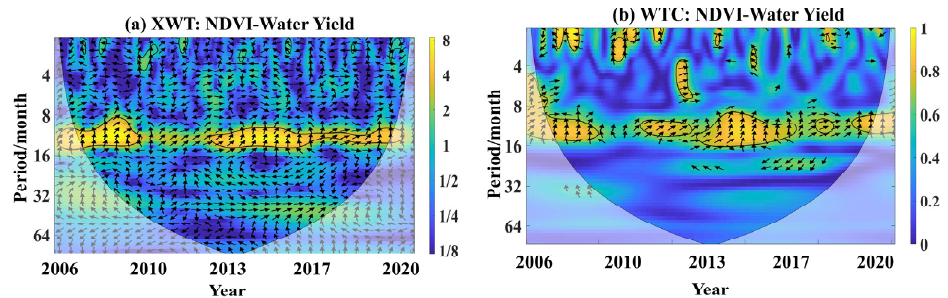
Figure 9. Cross-wavelet results for NDVI and water yield.